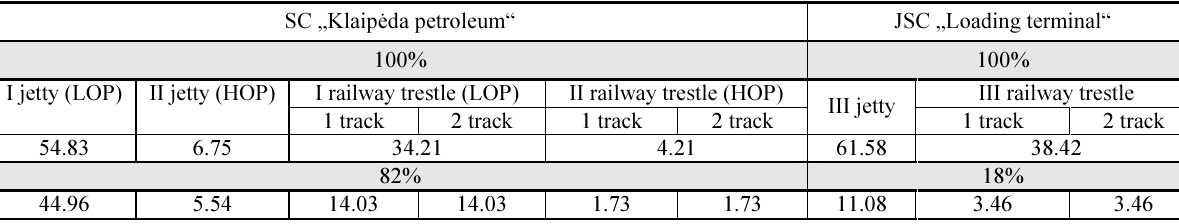
Table 1. Loading indicator (%) calculation scheme SC „Klaipėda